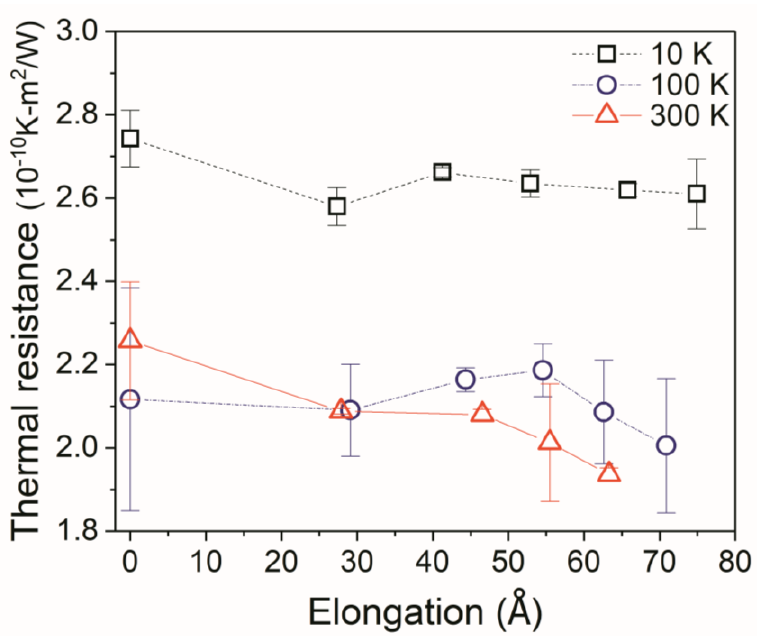
Figure 5. Interfacial thermal resistance as a function of elongation in SWCNT–graphene junction structure at different temperatures. The SWCNT pillar height is 200 nm and the graphene floor size between junctions is 15 nm.